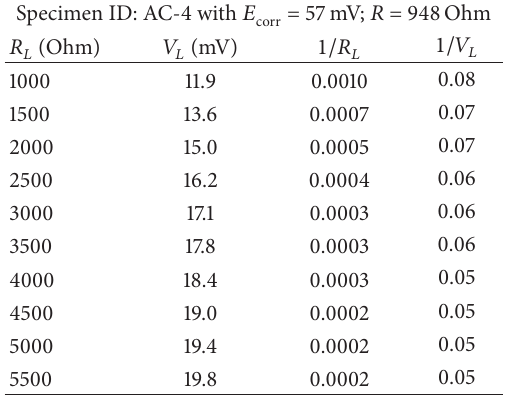
Figure 9: Comparison of 𝐼 , 𝜀 , 𝑅 𝑝 , and 𝐼 medium